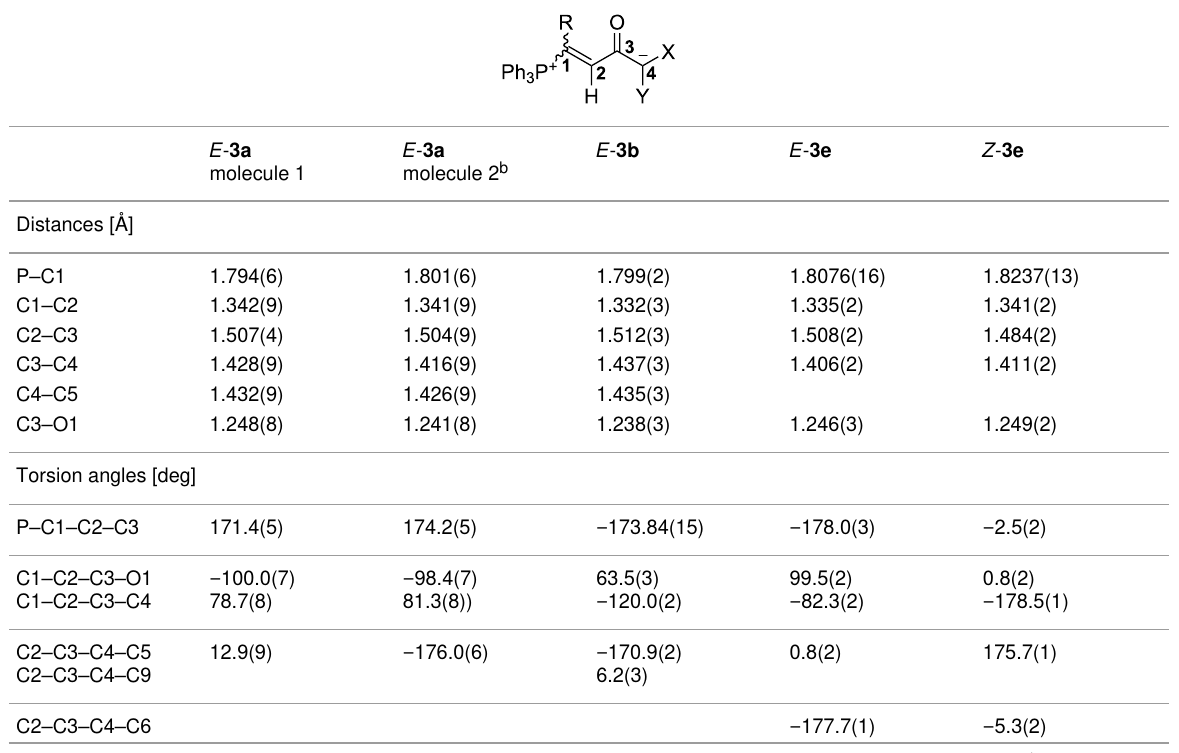
Table 1: Bond distances and torsion angles in betaines E - 3a , E - 3b , E - 3e , and Z - 3e based on XRD data.